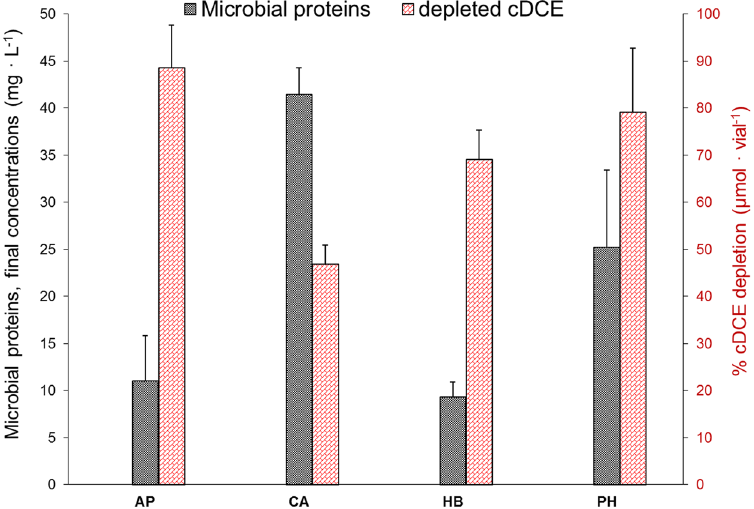
Figure 2. Microbial concentration, estimated as microbial protein content, and depletion of cDCE (% out of the initial amount) after 10 incubation days for the cultures enriched on 50 mg∙L − 1 acetophenone ( AP ), trans - cinnamic acid ( CA ), p -hydroxybenzoic acid ( HB ) and phenethyl alcohol ( PH ). The error bars indicate the standard deviation calculated on the basis of three biological replicates.